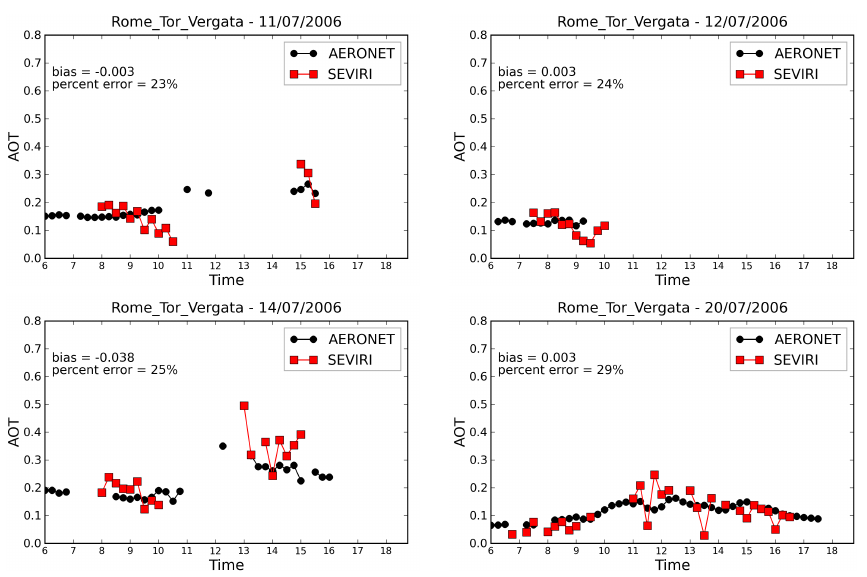
Fig. 6. Same as Fig. 5 but for Rome Tor Vergata station for days: 11, 12, 14 and 20 on July 2006.